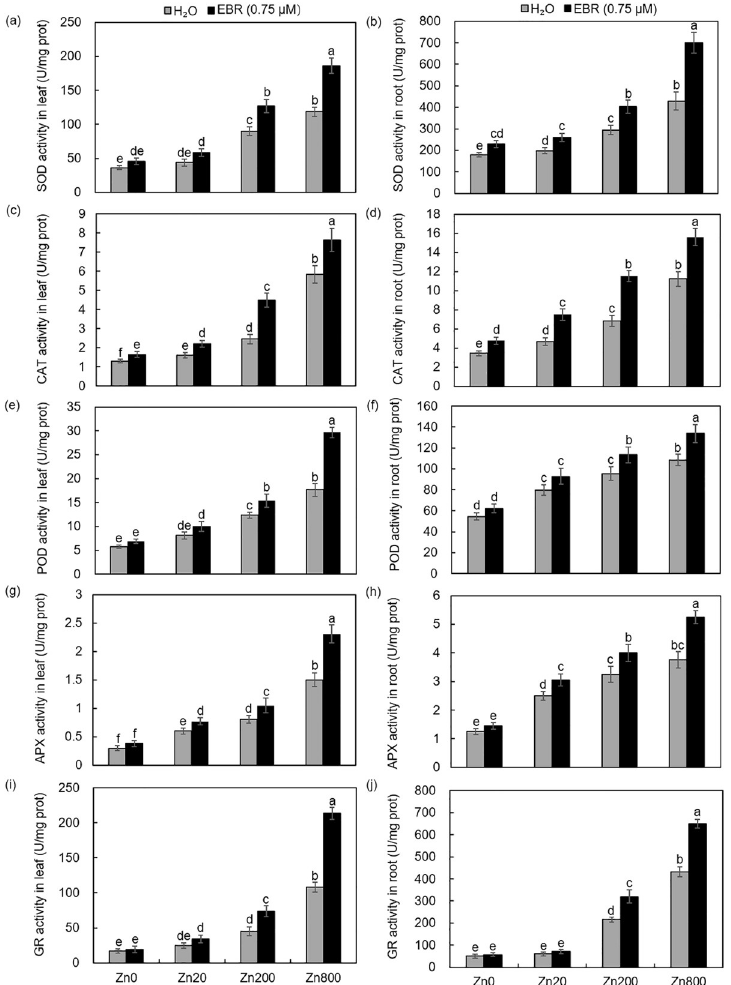
Fig 4. Antioxidant enzymatic activities in leaves and roots of S . lineare upon Zn and EBR treatments. (a, b) SOD activities; (c, d) CAT activities; (e, f) POD activities; (g, h) APX activities; (i, j) GR activities.